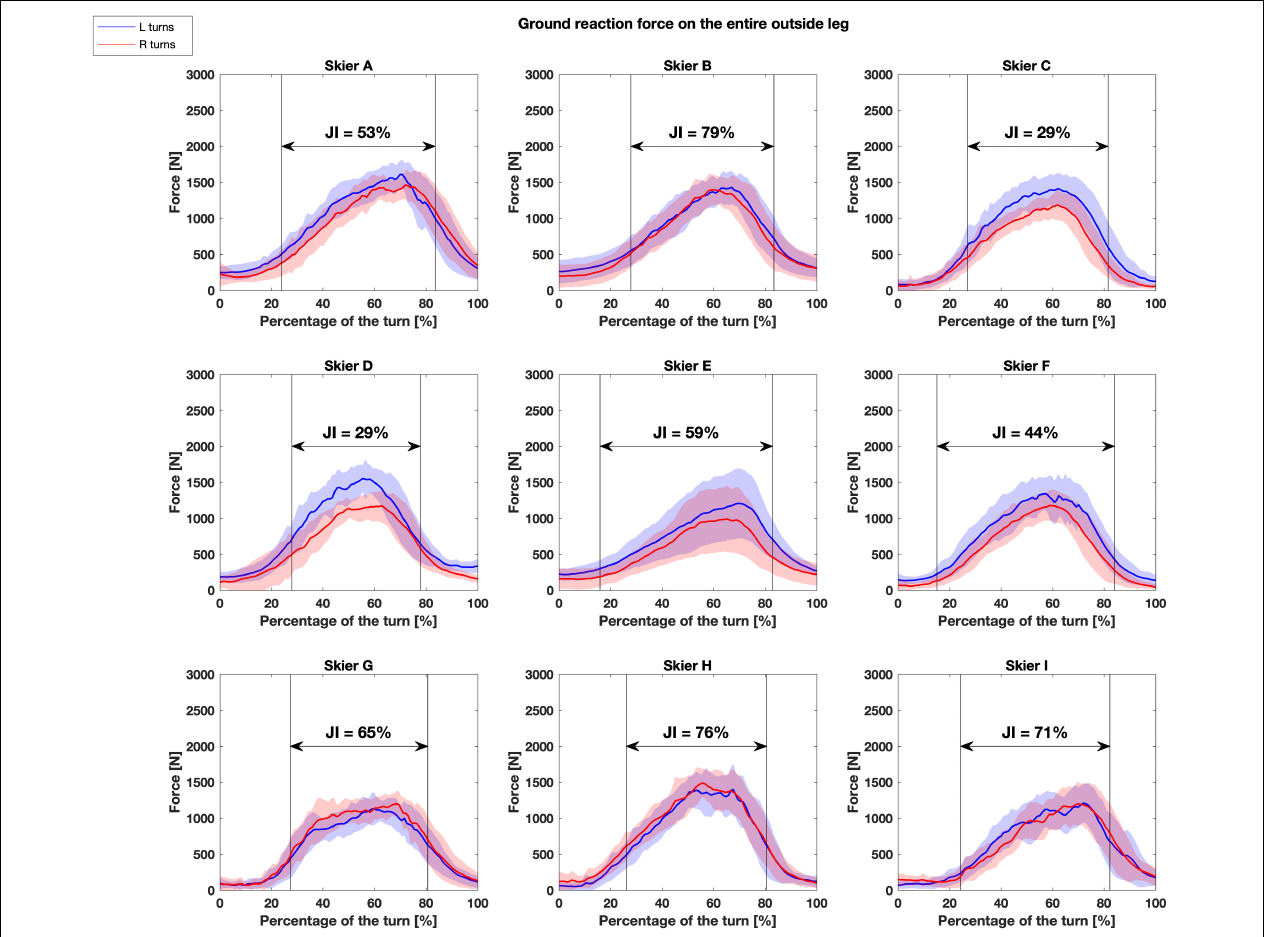
FIGURE 2 | Evolution of the ground reaction forces (GRFs) on the entire outside foot during left (blue) and right (red) turns for all nine elite alpine skiers (A-I) in order to compare the Jaccard Index (JI) during the steering phase. The vertical lines indicate the start and end of the turn and the steering phase is marked with a horizontal